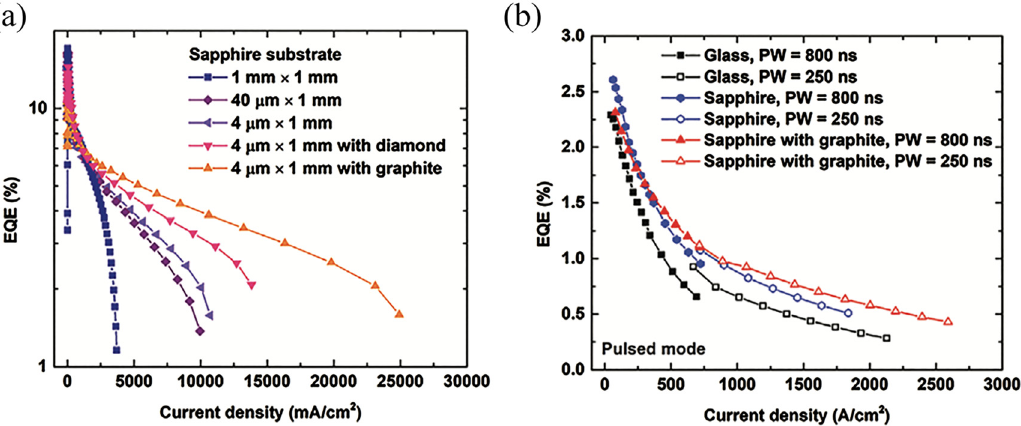
Figure10: (a)EQE-currentdensitycurvesofperovskiteLEDswithdifferentactiveareas,substratesandheatspreaders.(b)EQE-currentdensity curvesofperovskiteLEDswithdifferentsubstrates,spreadersunderdifferentelectricalpulses.Reproducedwithpermission[68].Copyright© 2020, WILEY ‐ VCH Verlag GmbH & Co. KGaA,